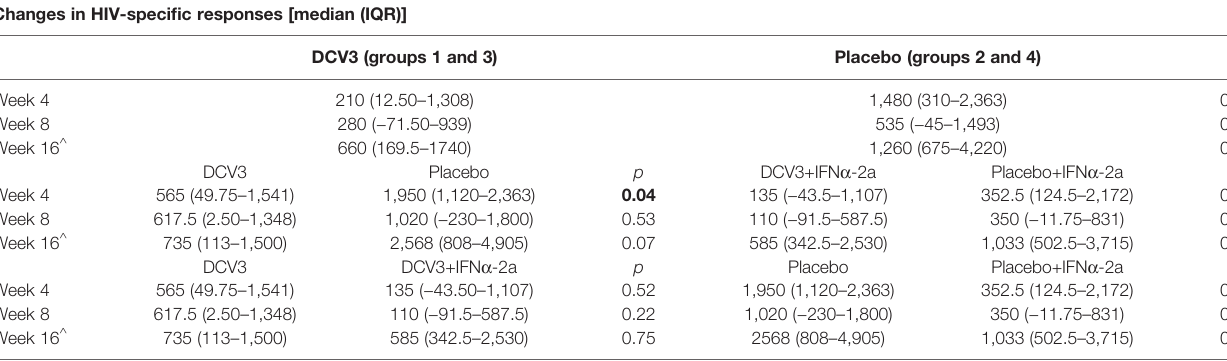
Bold means statistically signi fi